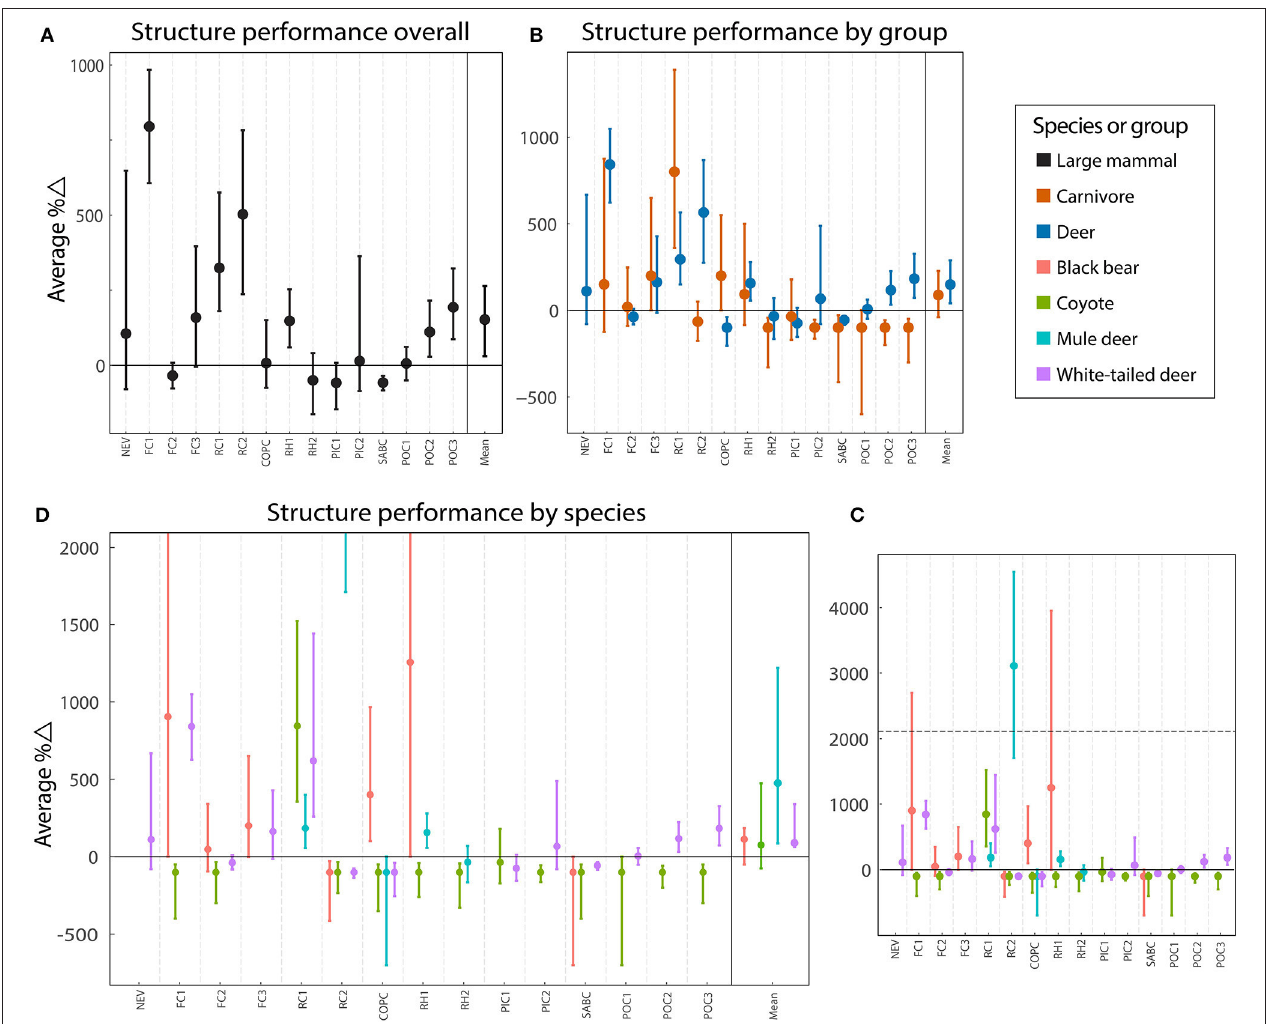
FIGURE 3 | Average percent difference in performance between movements at wildlife crossing structures and in the surrounding habitat for each site and all averaged across sites for species and species groups. Observations are subdivided from all large mammals (A) , to species groups (carnivore and deer) (B) , to individual species (black bear, coyote, white-tailed deer, and mule deer) (C) . To make smaller values easier to see, the y-axis in the plot displaying performance by species has been expanded and truncated (D) . The horizontal, dotted line in (C) indicates the truncation point for (D) . Weighted mean values across all applicable sites are included in the far right of the panels. Error bars indicate bootstrap BCa 95% confidence